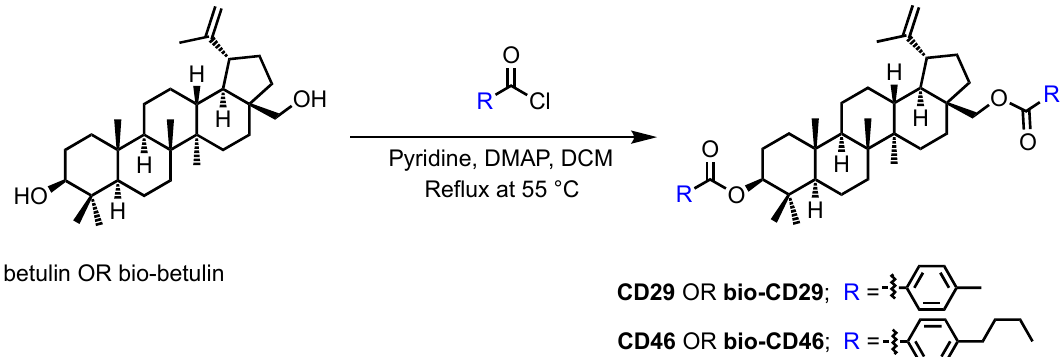
Figure 1. Synthesis of the chiral dopants CD29 and CD46 from commercially available natural betulin and the synthesis of the chiral dopants bio-CD29 and bio-CD46 from bio-betulin (which itself was prepared by fermentation).